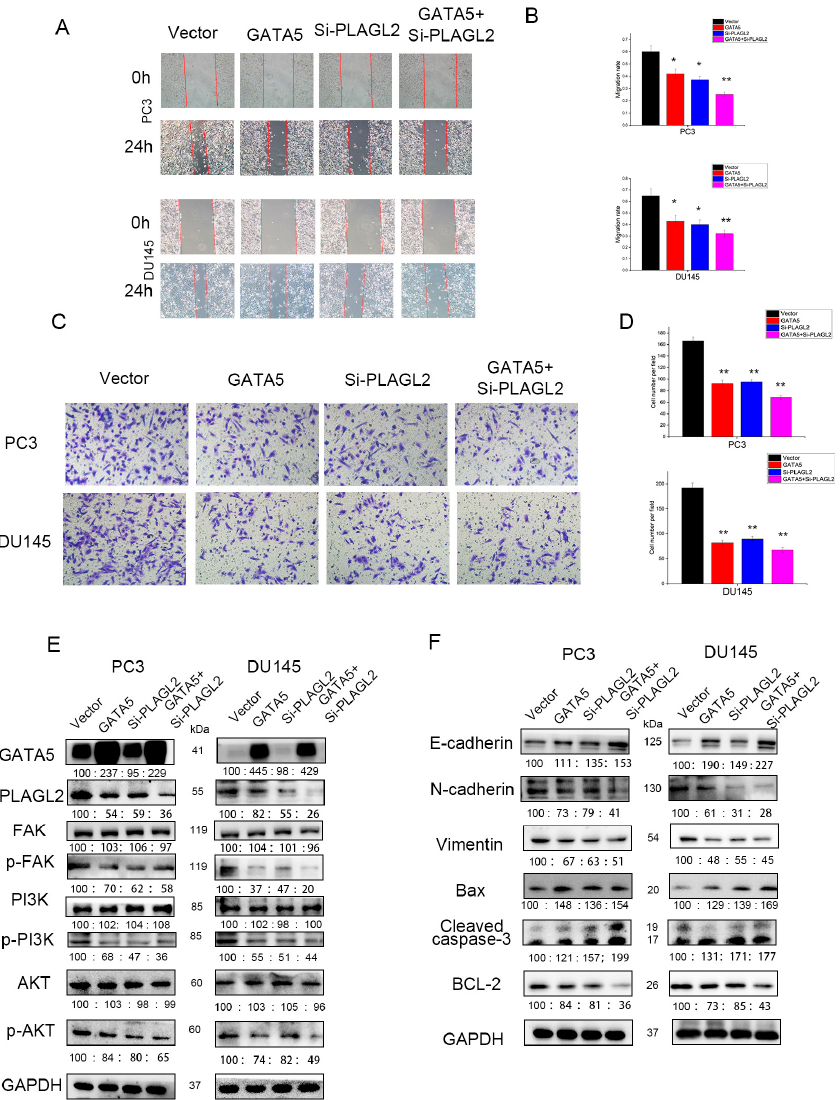
Figure 7. GATA5 participates in PCa progression through regulating PLAGL2 via the FAK/PI3K/AKT pathway. ( A , B ) A wound-healing experiment was utilized to explore the ability of migration in the four groups. ( C , D ) Transwell invasion assays demonstrated that knockdown of PLAGL2 in the pc-GATA5 group further reduced the number of cells that went through the chamber. ( E ) PLAGL2 knockdown enhanced the function of GATA5 overexpression in hindering the protein level of p-FAK, p-PI3K, as well as p-AKT. ( F ) GATA5 affected cell apoptosis and EMT by regulating PLAGL2. Data are presented as mean ± SD of at least three experiments. * p < 0.05 and ** p < 0.01.